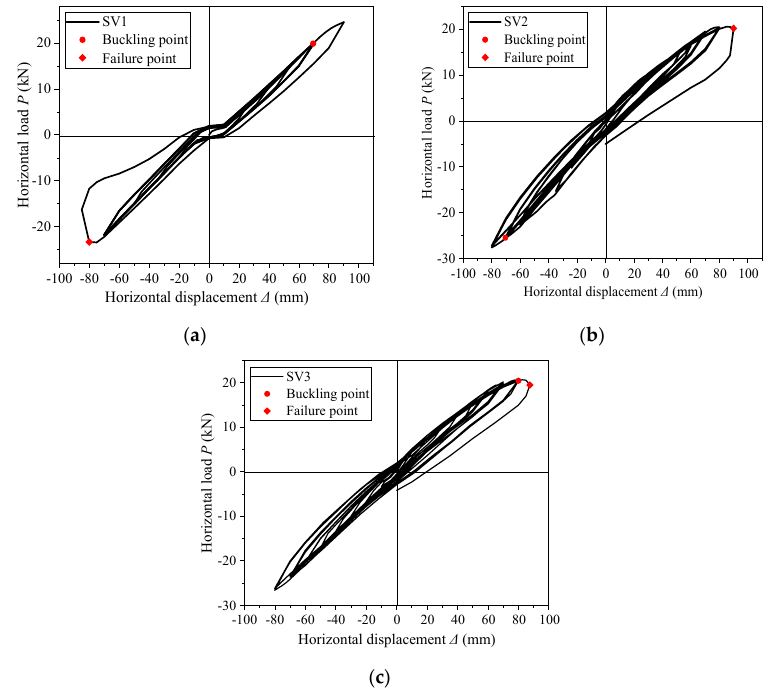
Figure 10. Hysteresis curves. ( a ) SV1; ( b ) SV2; ( c ) SV3.